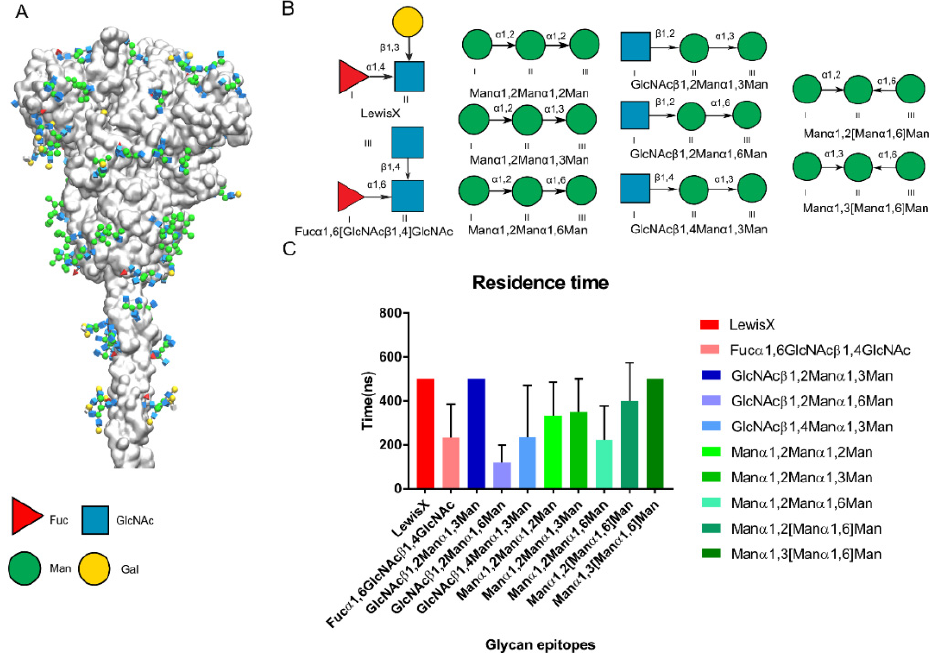
Figure 6. Predicted glycan epitopes on the Spike of SARS-CoV-2 recognized by DC-SIGN. ( A ) First frame of Spike protein [26]. Glycan epitopes on the spike protein shown in the 3D-SNFG [38]. ( B ) The potential epitopes on Spike of SARS-CoV-2 for the DC-SIGN recognition. The antenna epitopes of N -type glycostructures on Spike are collected which contained the Fuc, Man, GlcNAc. ( C ) Residence time of potential glycan epitopes of SARS-CoV-2 Spike in triple replicas. Pictures are made by the VMD.